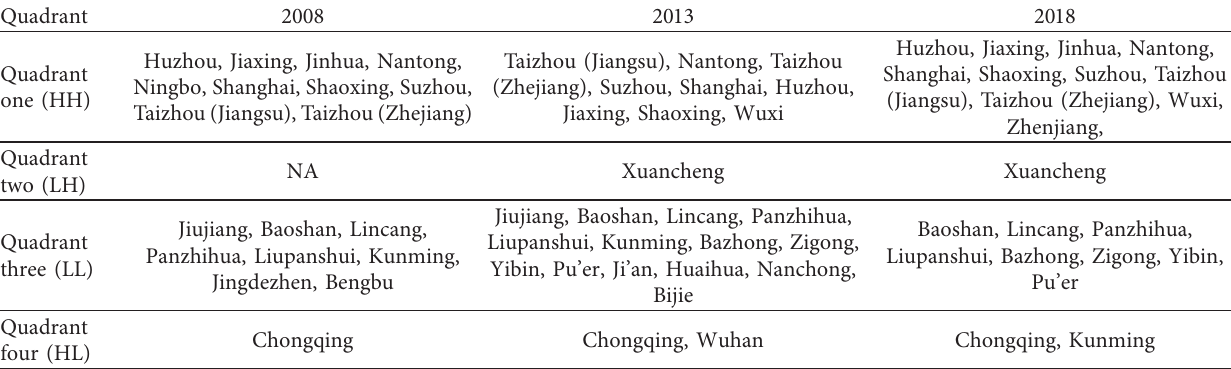
Table 2: LISA clustering results of innovation output of YREZ based on the Moran scatterplot. Quadrant